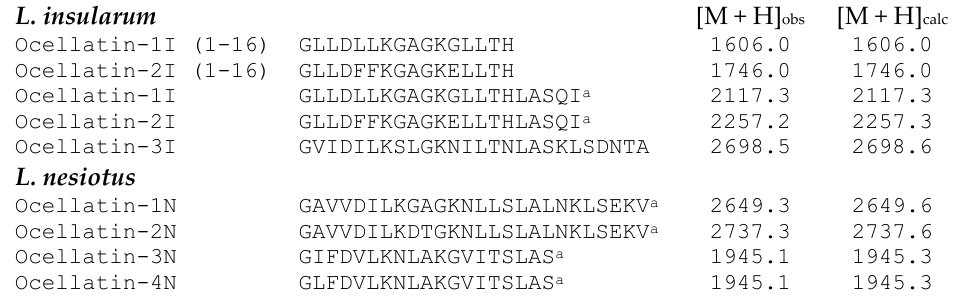
Figure 2. Elution profile on a semipreparative Vydac C ‐ 18 column of pooled skin secretions from seven Leptodactylus nesiotus frogs after prior concentration on Sep ‐ Pak cartridges. The dashed line shows the concentration of acetonitrile in the eluting solvent. Peaks 1–4 contain ocellatins that were purified to near homogeneity by further chromatography on Vydac C ‐ 8 and dimethylphenyl columns. Absorbance was monitored at 214 nm.